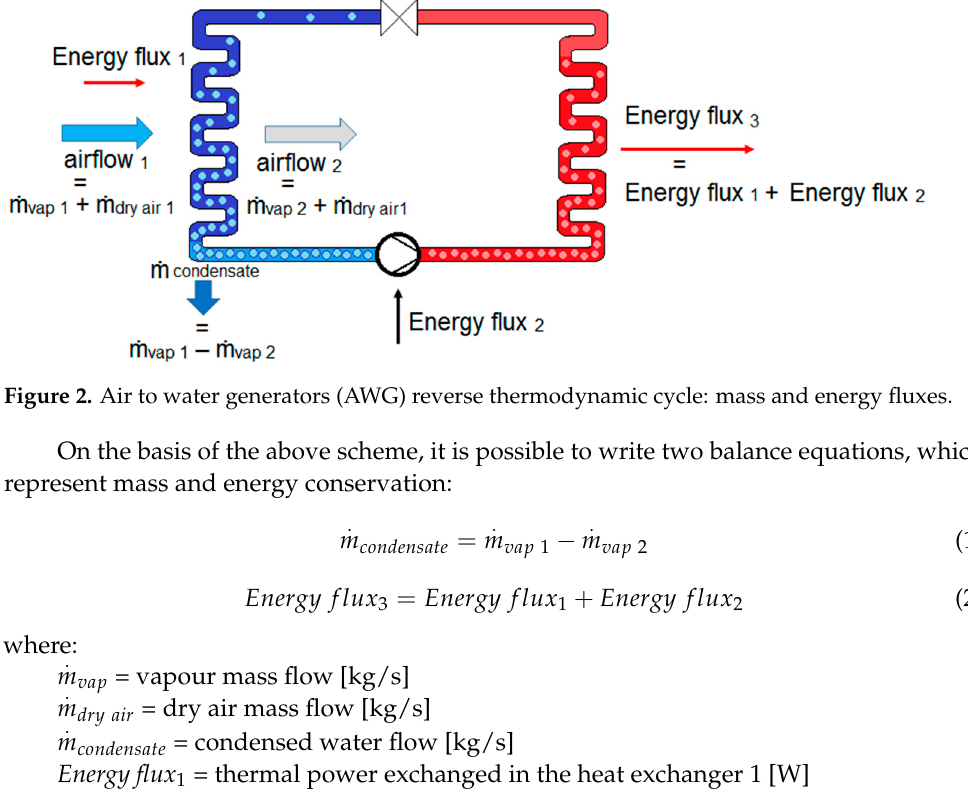
Figure 2. Air to water generators (AWG) reverse thermodynamic cycle: mass and energy fluxes.